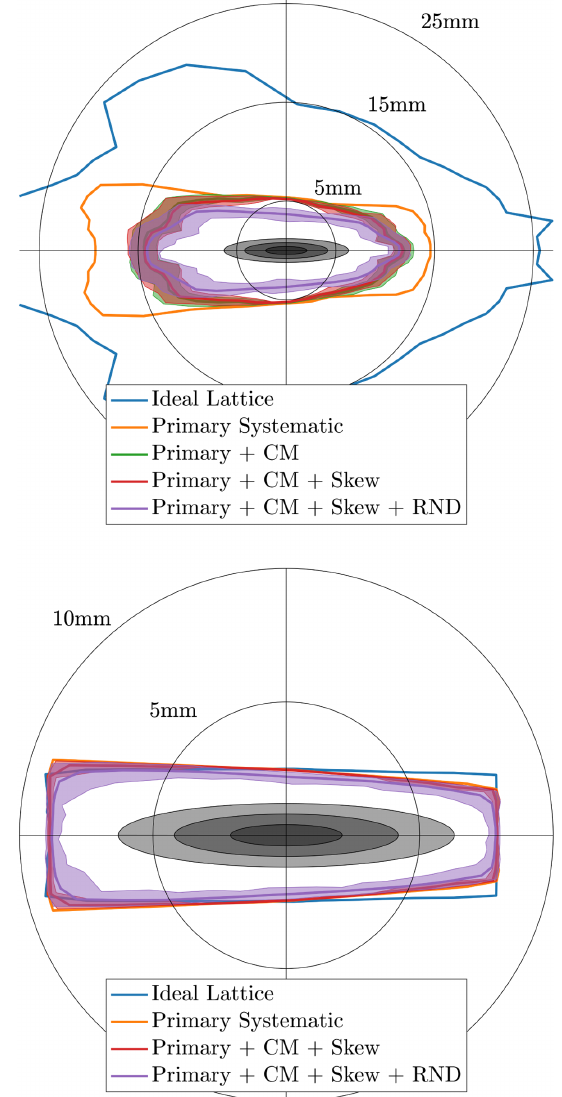
FIG. 8. Impact of magnet multipoles on the dynamic aperture. The different colors correspond to different multipole error configurations, e.g., no multipole errors (ideal lattice, blue), full multipole errors including all corrector coils, and random multi- poles (purple). The shaded areas represent 2 σ of the evaluations. Shown are calculations without (top) and including (bottom) physical apertures. The grey ellipses reflect 1 σ ; 2 σ , and 3 σ of the ideal injected beam during